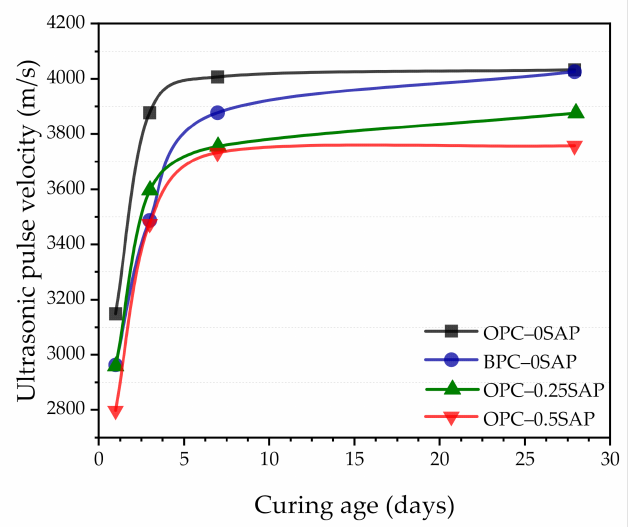
Figure 15. Variation in ultrasonic pulse velocity (UPV) of the mixture with the curing